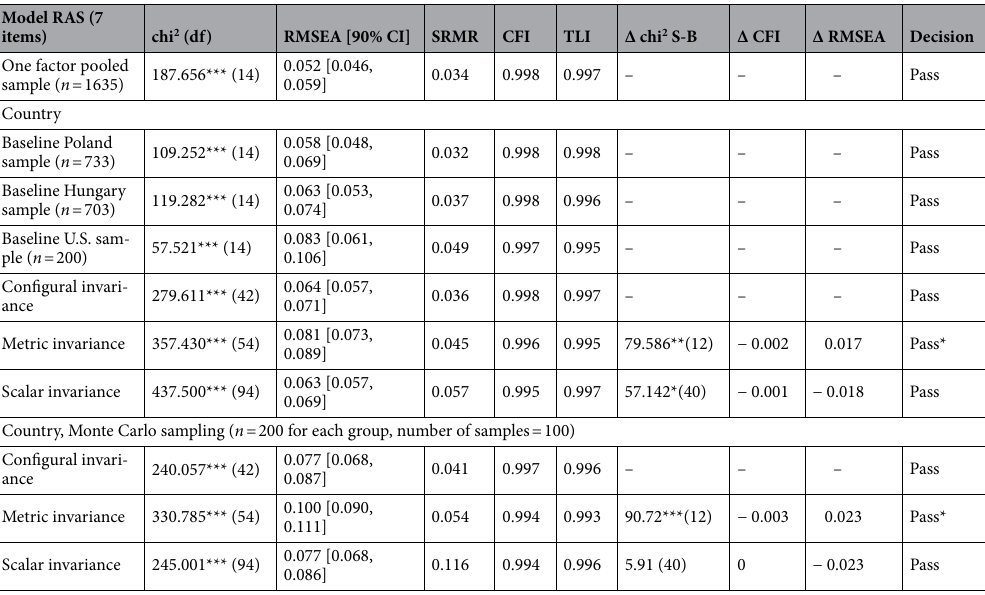
Table 2. Model fit for multiple group models and measurement invariance comparisons across countries. Differences between groups are on the loadings of item RAS1: λ PL = 0.887 ± 0.09, λ HU = 0.889 ± 0.09, λ US = 0.865 ± 0.09. After relax this parameter constraint invariance was achieved: Δ RMSEA = 0.009 < 0.015 and Δ CFI = -0.001 < 0.010. * based on SRMR < 0.06, because CFI and RMSEA indices are inconsistent. CFI comparative fit index, TLI Tucker–Lewis index, RMSEA root mean square error of approximation, CI confidence interval, df degrees of freedom, SRMR squared root mean residuals, S-B Satorra–Bentler correction, Δ comparisons of nested model: configural-metric, metric-scalar.